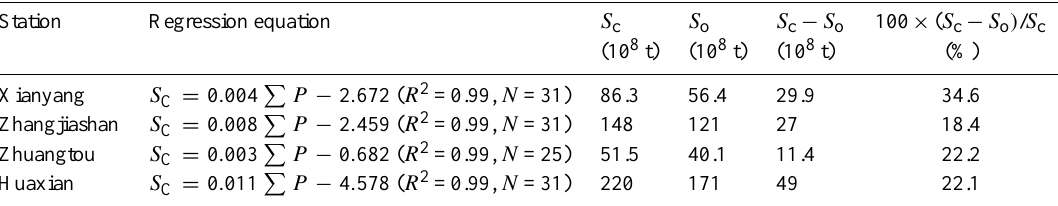
Table 5. Cumulative sediment discharge ( S c ) calculated by the linear regression equations before the transition years, observed cumulative sediment discharge ( S o ) and reduction of cumulative sediment discharge ( S c − S o , 10 8 t%) after transition years in the Wei River basin ( N =years, P =precipitation).